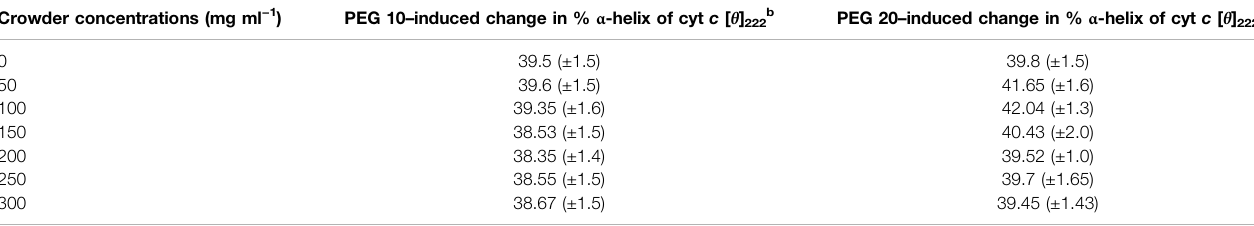
TABLE 1 | Percentage of α -helical content of cyt c in the absence and presence of different concentrations of PEG 10 and PEG 20, estimated from the far-UV CD measurements at 222 nm a . Crowder concentrations (mg ml − 1 ) PEG 10 – induced change in % α -helix of cyt c [ θ ] 222b PEG 20 – induced change in % α -helix of cyt c [ θ ]